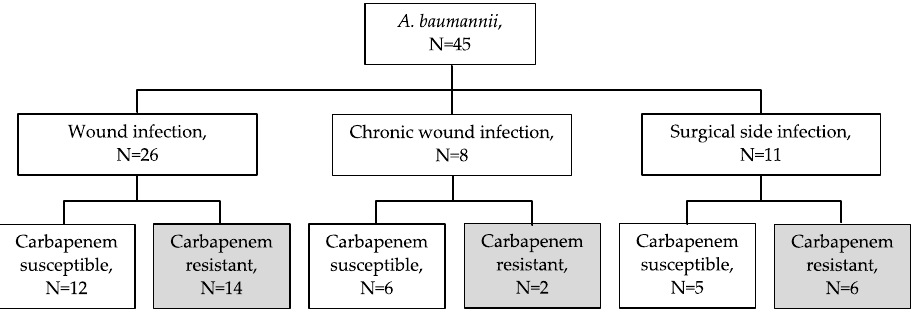
Figure 1. Distribution of Acinetobacter baumannii isolates according to wound infection type and carbapenem susceptibility. Table 1. List of bacterial pathogens detected beside carbapenem-resistant Acinetobacter baumannii in wound infections ( n = 22).